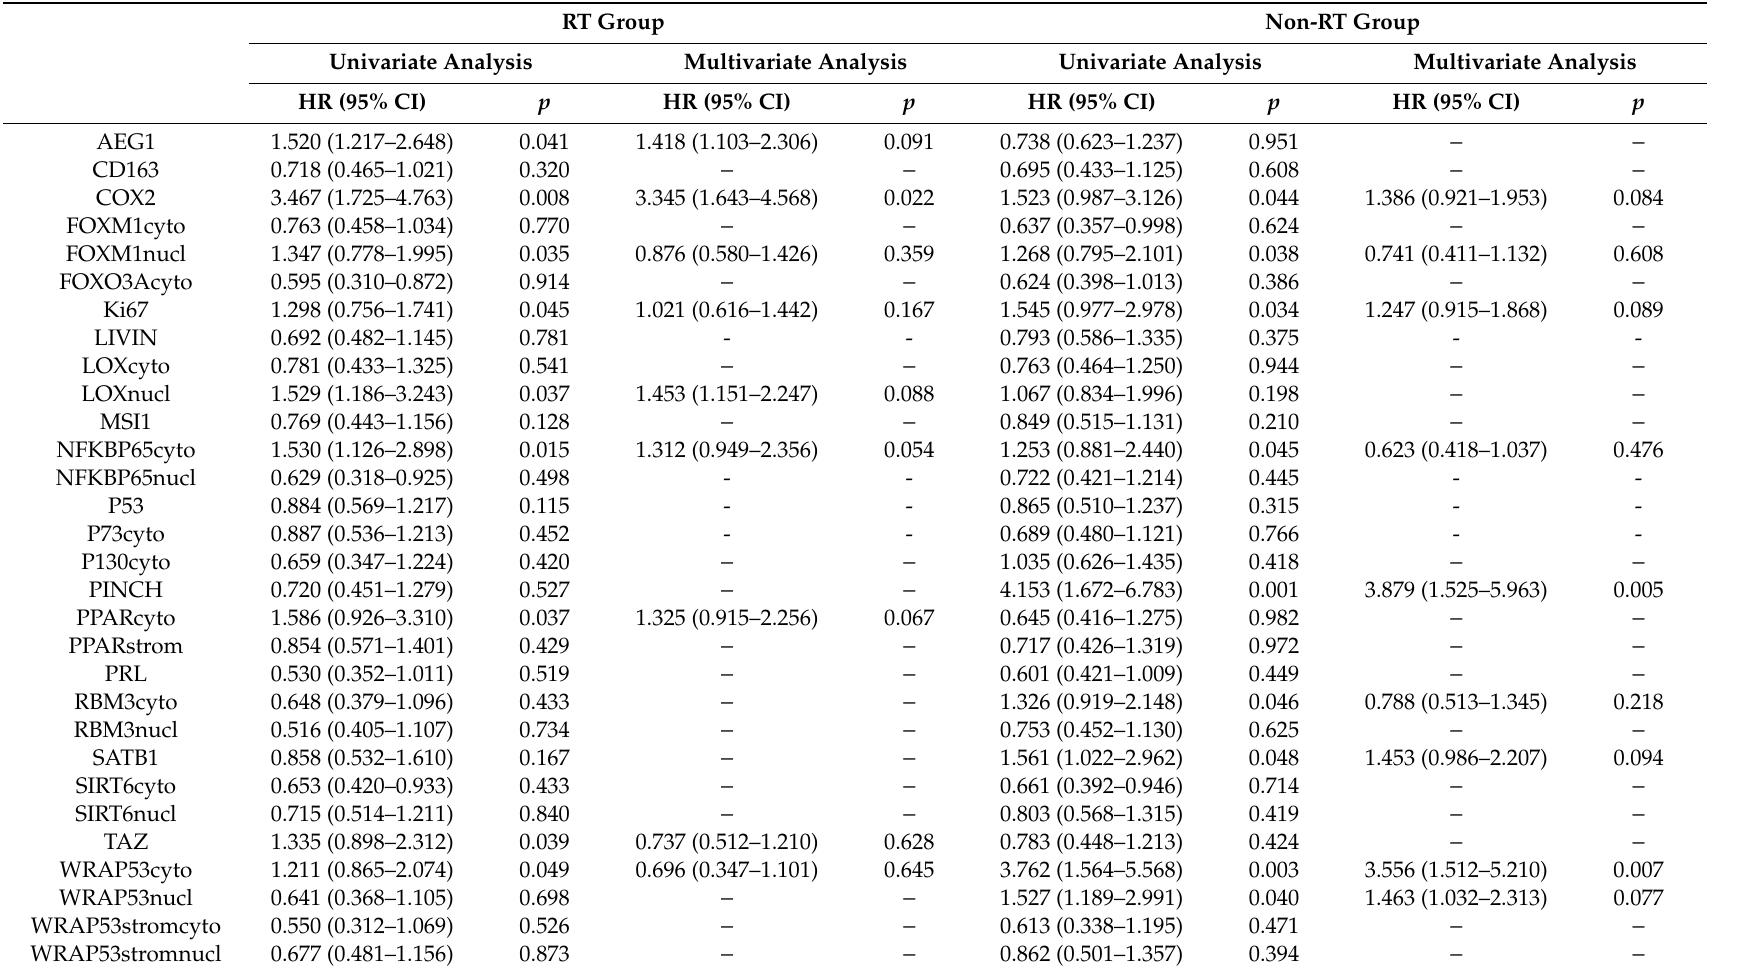
Table 3. Univariate and multivariate Cox proportional hazard models for disease free survival of di ff erent biomarkers. RT Group Non-RT Group Univariate Analysis Multivariate Analysis Univariate Analysis Multivariate